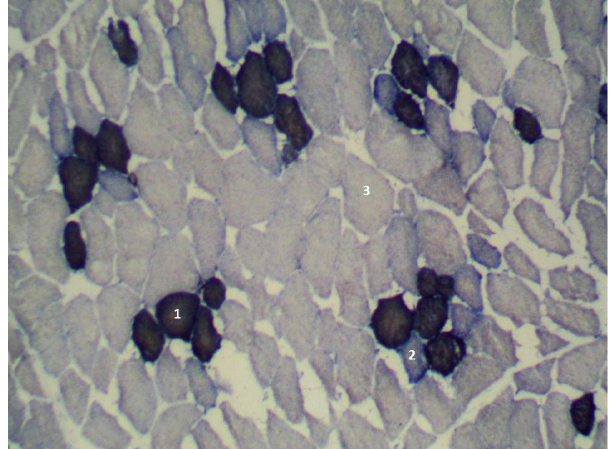
Figure 3. Cross section of the longissimus lumborum muscle in Pulawska pig. Magnified 100 times. STO is indicated by 1, FTO is indicated by 2 and FTG is indicated by